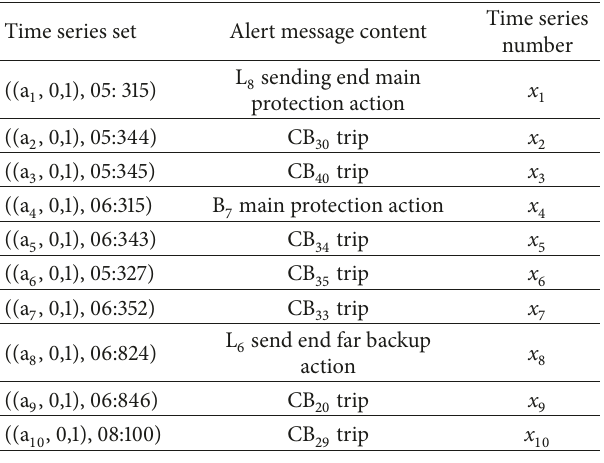
Table 9: Actual alarm information.